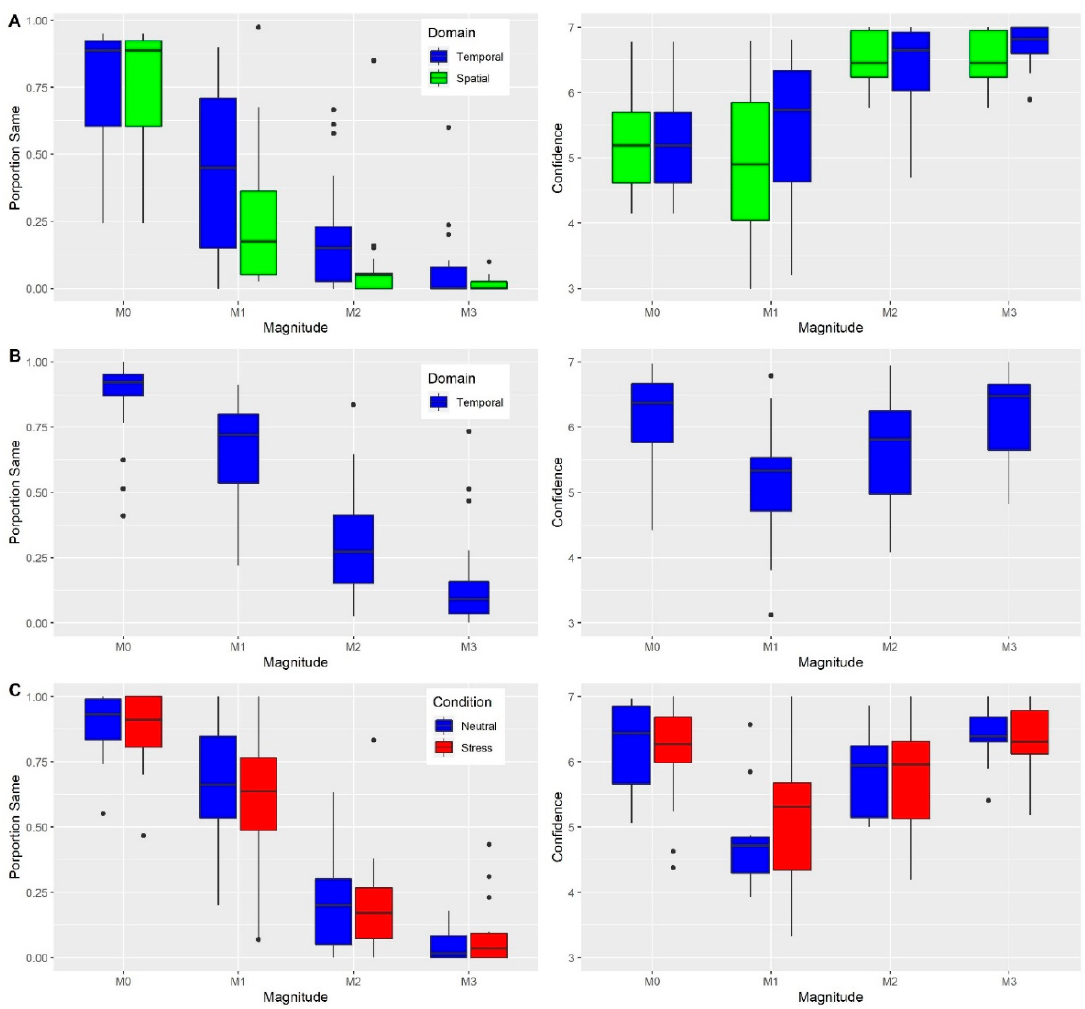
Figure 3. Judgments of SoA (left panels) and confidence (right panels) across three experiments (2–4; A – C ). In the left panels, the Y -axis is the proportion of trials in which participants responded that VH’s movement was the same as the actual movement, across the different magnitudes of alteration. Importantly, only in M0 (i.e., no alteration) was it correct to respond ‘same’. In the right panels, the Y -axis is the participants’ mean confidence rating (rated on a scale of 1–7) of their response to the agency question in which their response was correct. Lines within colored boxes are medians. ( A ) Experiment 2. Alterations were introduced in both the spatial (green) and temporal (blue) domain. ( B ) Experiment 3. Alterations were only introduced in the temporal domain. ( C ) Experiment 4. Alterations were introduced only in the temporal domain, and assessed in a neutral (blue) and stress (red) block.